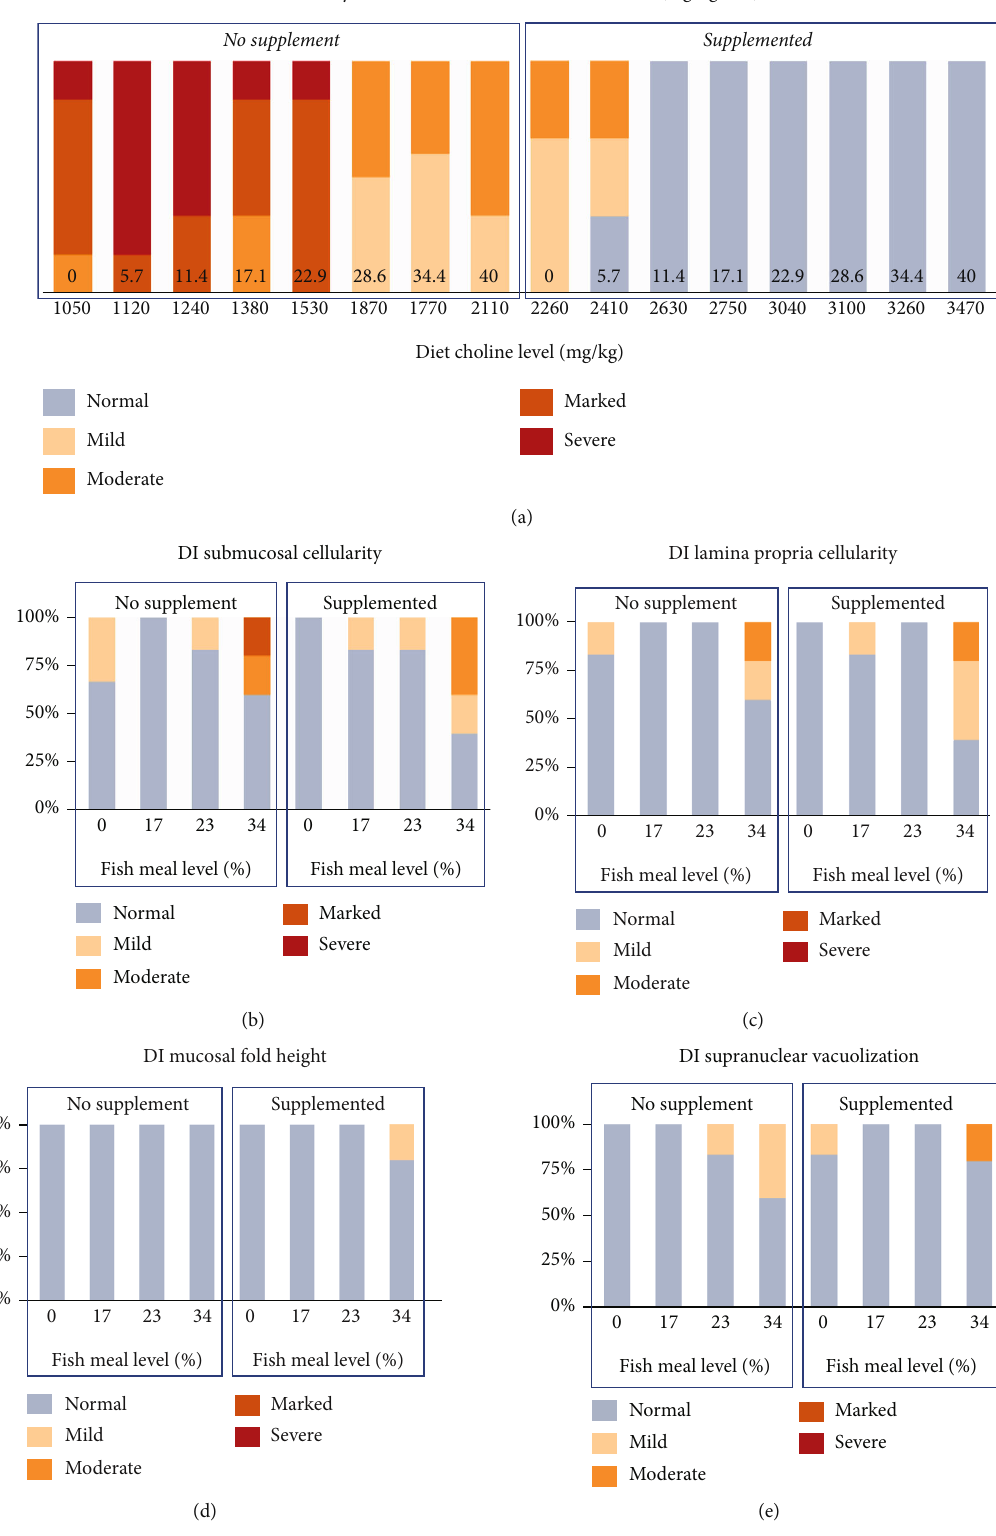
Figure 12: Results of histological examination of (a) pyloric caeca regarding the degree of enterocyte vacuolization (steatosis; numbers at the bottom of the columns indicate fi shmeal level), and (b – e) distal intestine in fl ammation as represented by the degree of increase in immune cell in fi ltration/cellularity in submucosa and lamina propria, mucosal fold height, and supranuclear vacuolization in fi sh fed diets with increasing levels of FM, without (No supplement) or with (Suppl) a mixture of 0.3% choline chloride, 0.05% β -glucan, and 0.05%